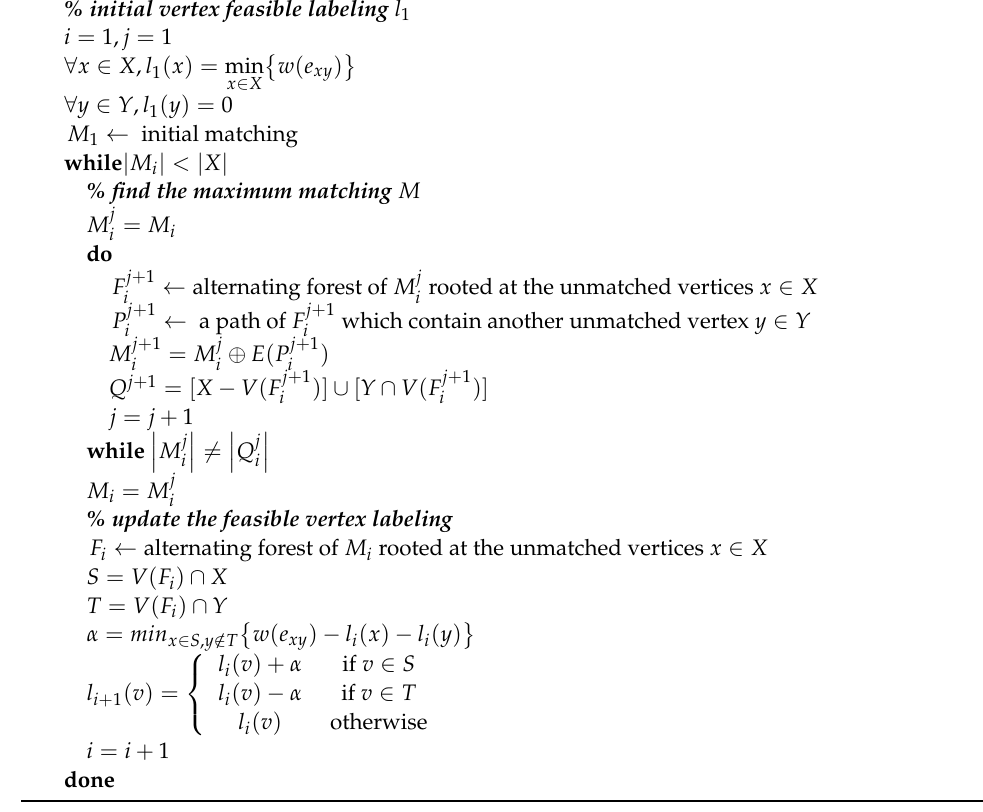
Algorithm 1. Pseudocode for the Hungarian algorithm Function Hungarian-Algorithm ( G